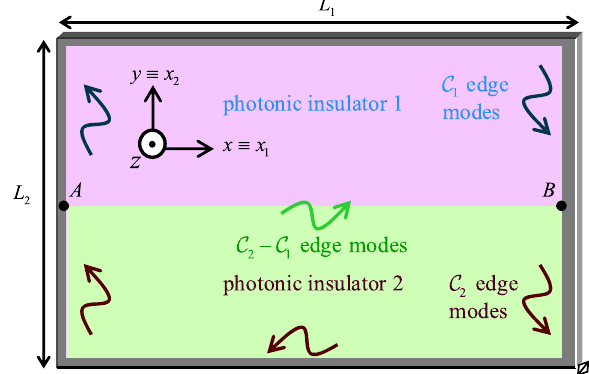
FIG. 2. Illustration of the bulk-edge correspondence principle. A cavity (terminated with “ opaque-type ” lateral walls) is filled with two photonic insulators. The points A and B represent the two